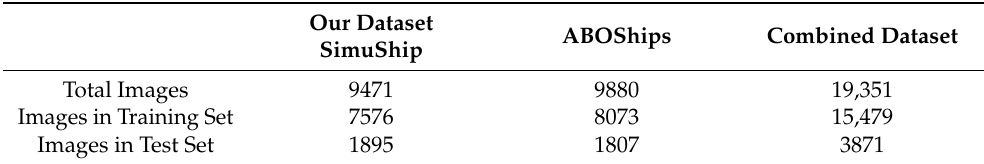
Figure 5. Images from SimuShips dataset Table 3. Dataset for training the object detection model. We combine real images from Turku River from ABOShips with simulated ones.